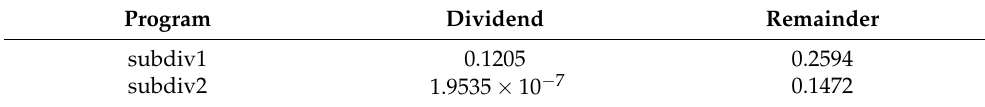
Table 3. Total error of dividend and remainder.